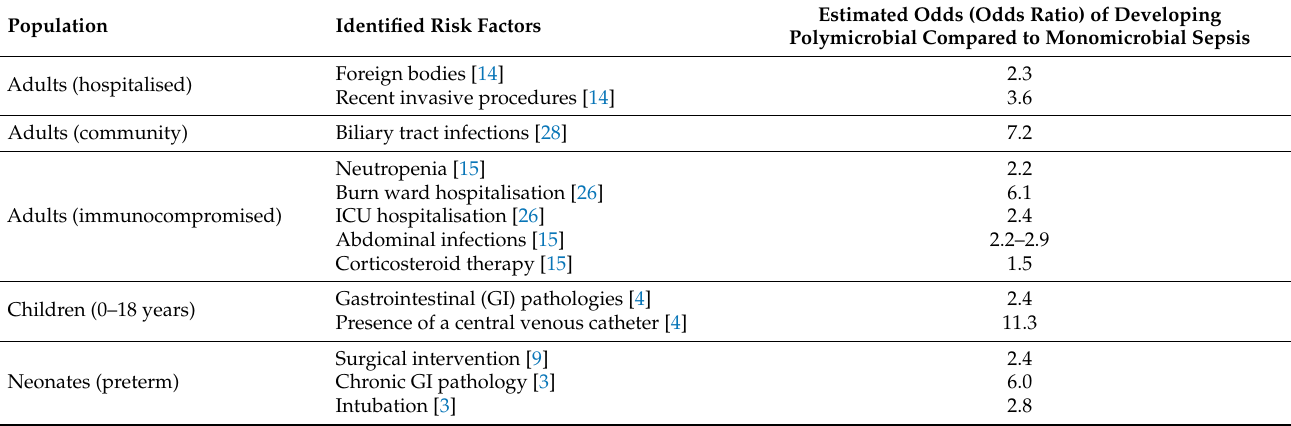
Table 2. Risk factors for developing polymicrobial